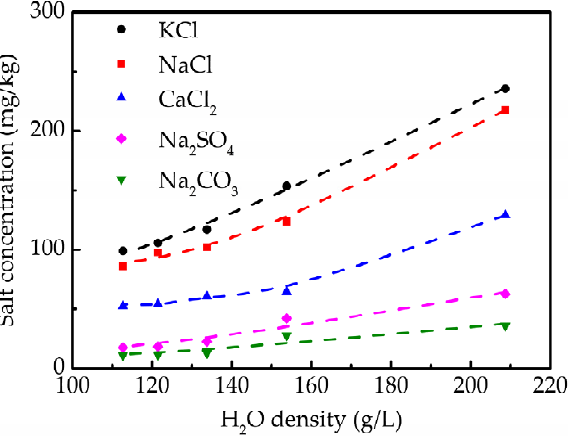
Figure 4. Concentrations of inorganic salts as a function of H 2 O density (dashed line—Equation